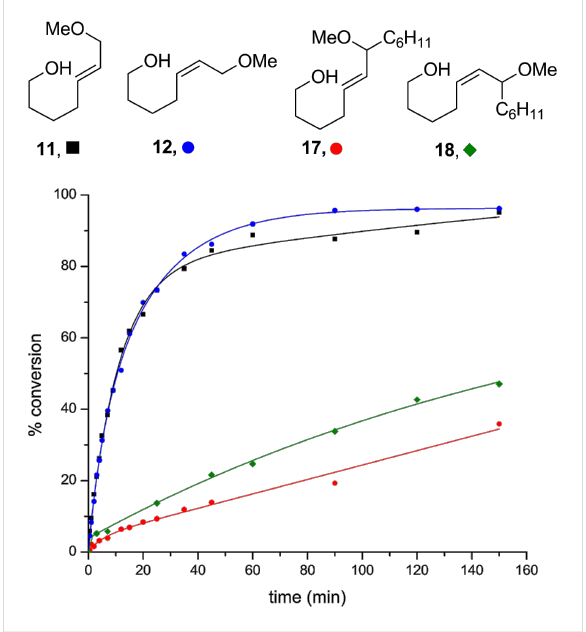
Figure 6: Comparison of 1° and 2° allylic ethers. Conditions: 5 mol % Au[P( t -Bu) 2 ( o -biphenyl)]SbF 6 , CH 2 Cl 2 , MS 4 Å.